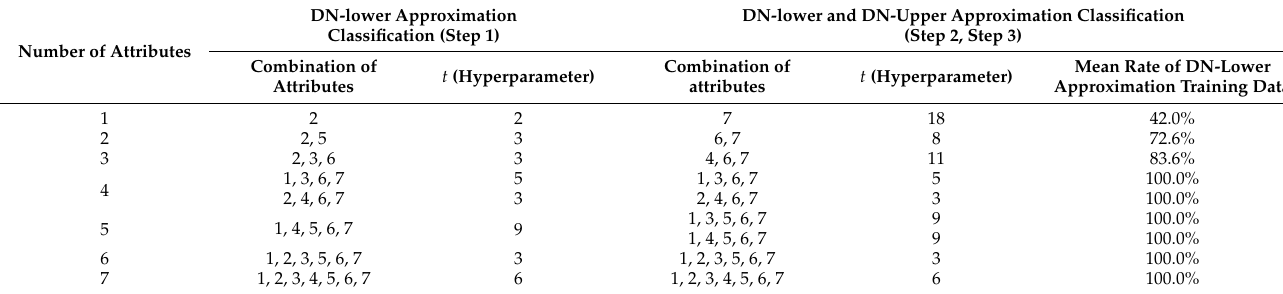
Table 6. Optimal hyperparameter of the DNRS model for Raisin.